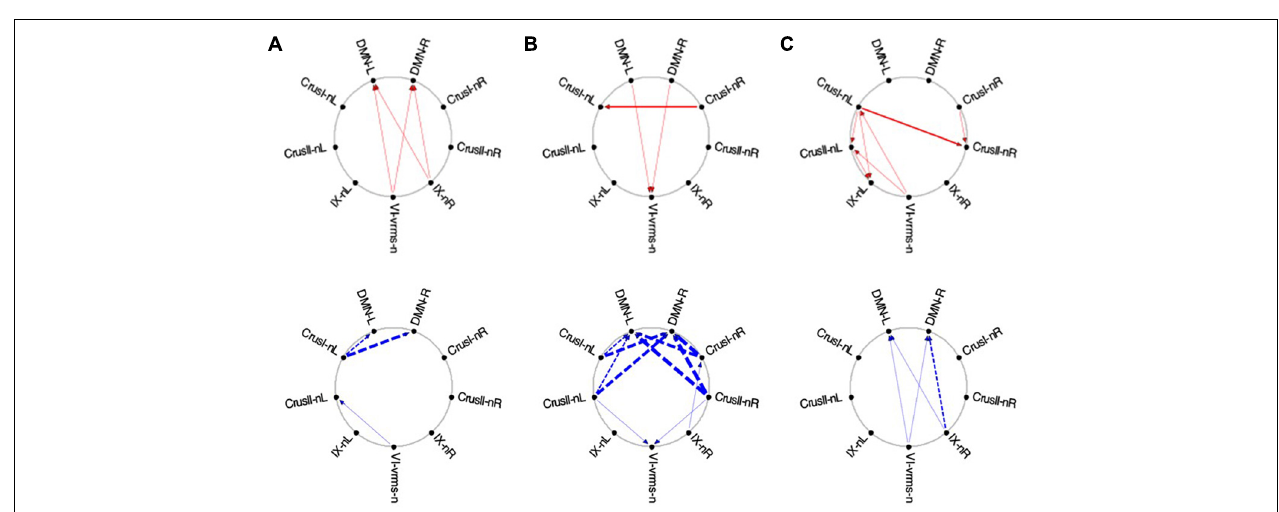
FIGURE 13 | Average Granger causal connectivity maps in the EM condition for the task-negative network (shown in the same format and significance criteria as Figure 10 ). The congruent influences were dramatically weaker than for the visualization task, while inverse influences were reorganized. Influences flow inconsistently from and to the DM at different times, but strongly to the DMN from the Crus ROIs for inverse influences during the second